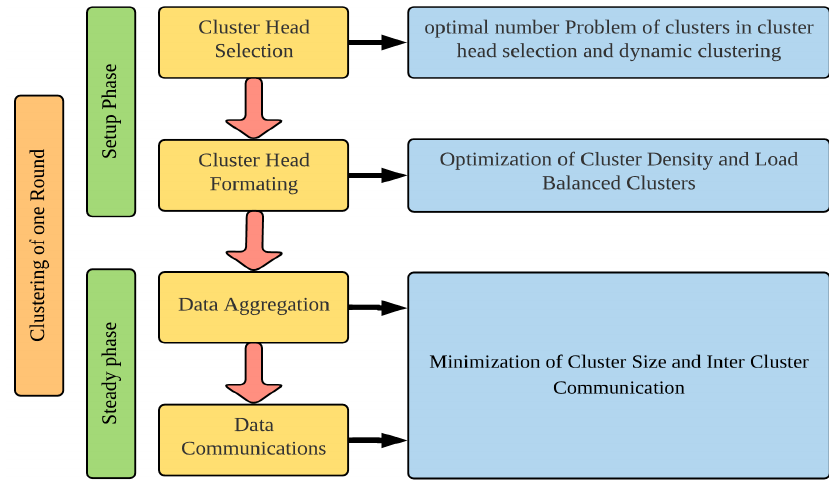
Figure 5. Clustering optimization methods in a WSN.